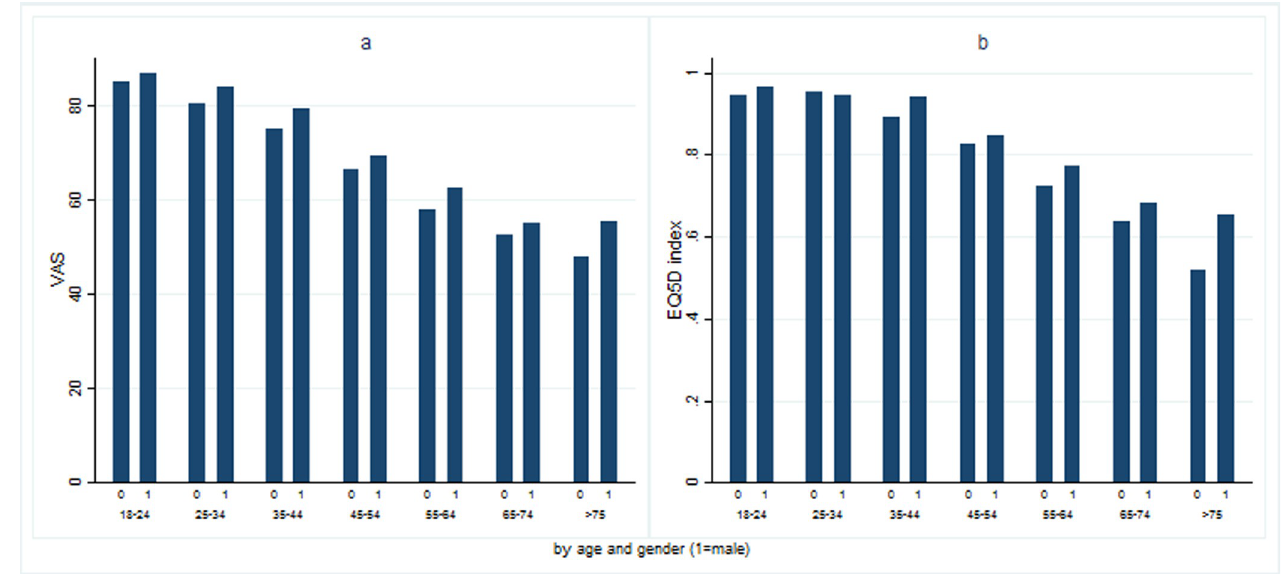
Fig 2. Mean VAS and index scores by age and gender groups. a. VAS score, b. EQ-5D index score.